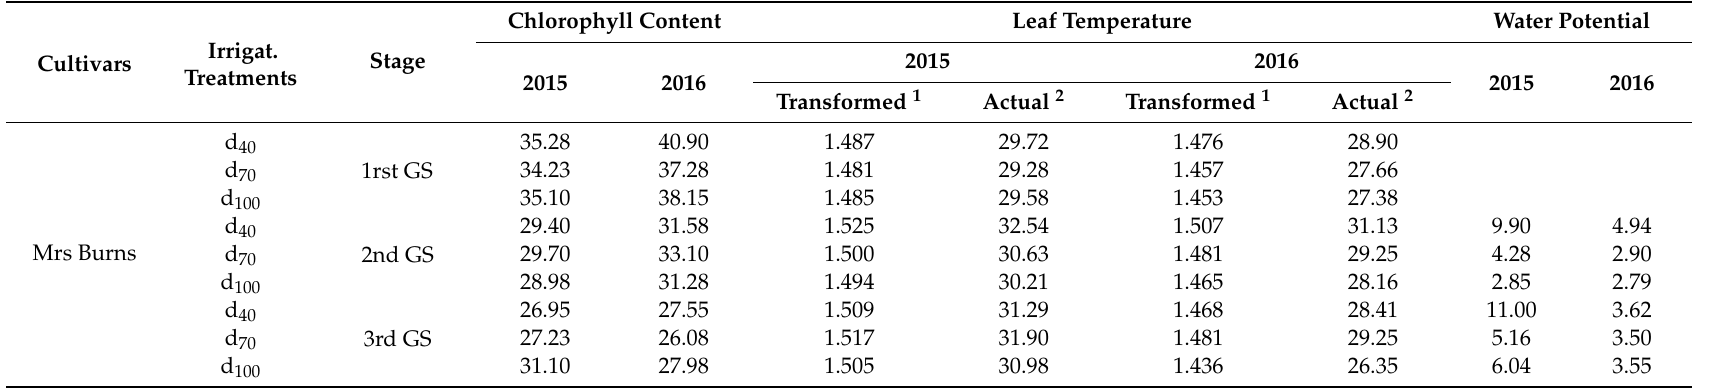
Table 3. Combined e ff ect of Years (2015, 2016), Cultivars, Irrigation treatments and Stages of development on Chlorophyll content, Leaf temperature and Water potential. Data presented are mean values, where LSD is the least significant di ff erence at the 0.05 significance level.